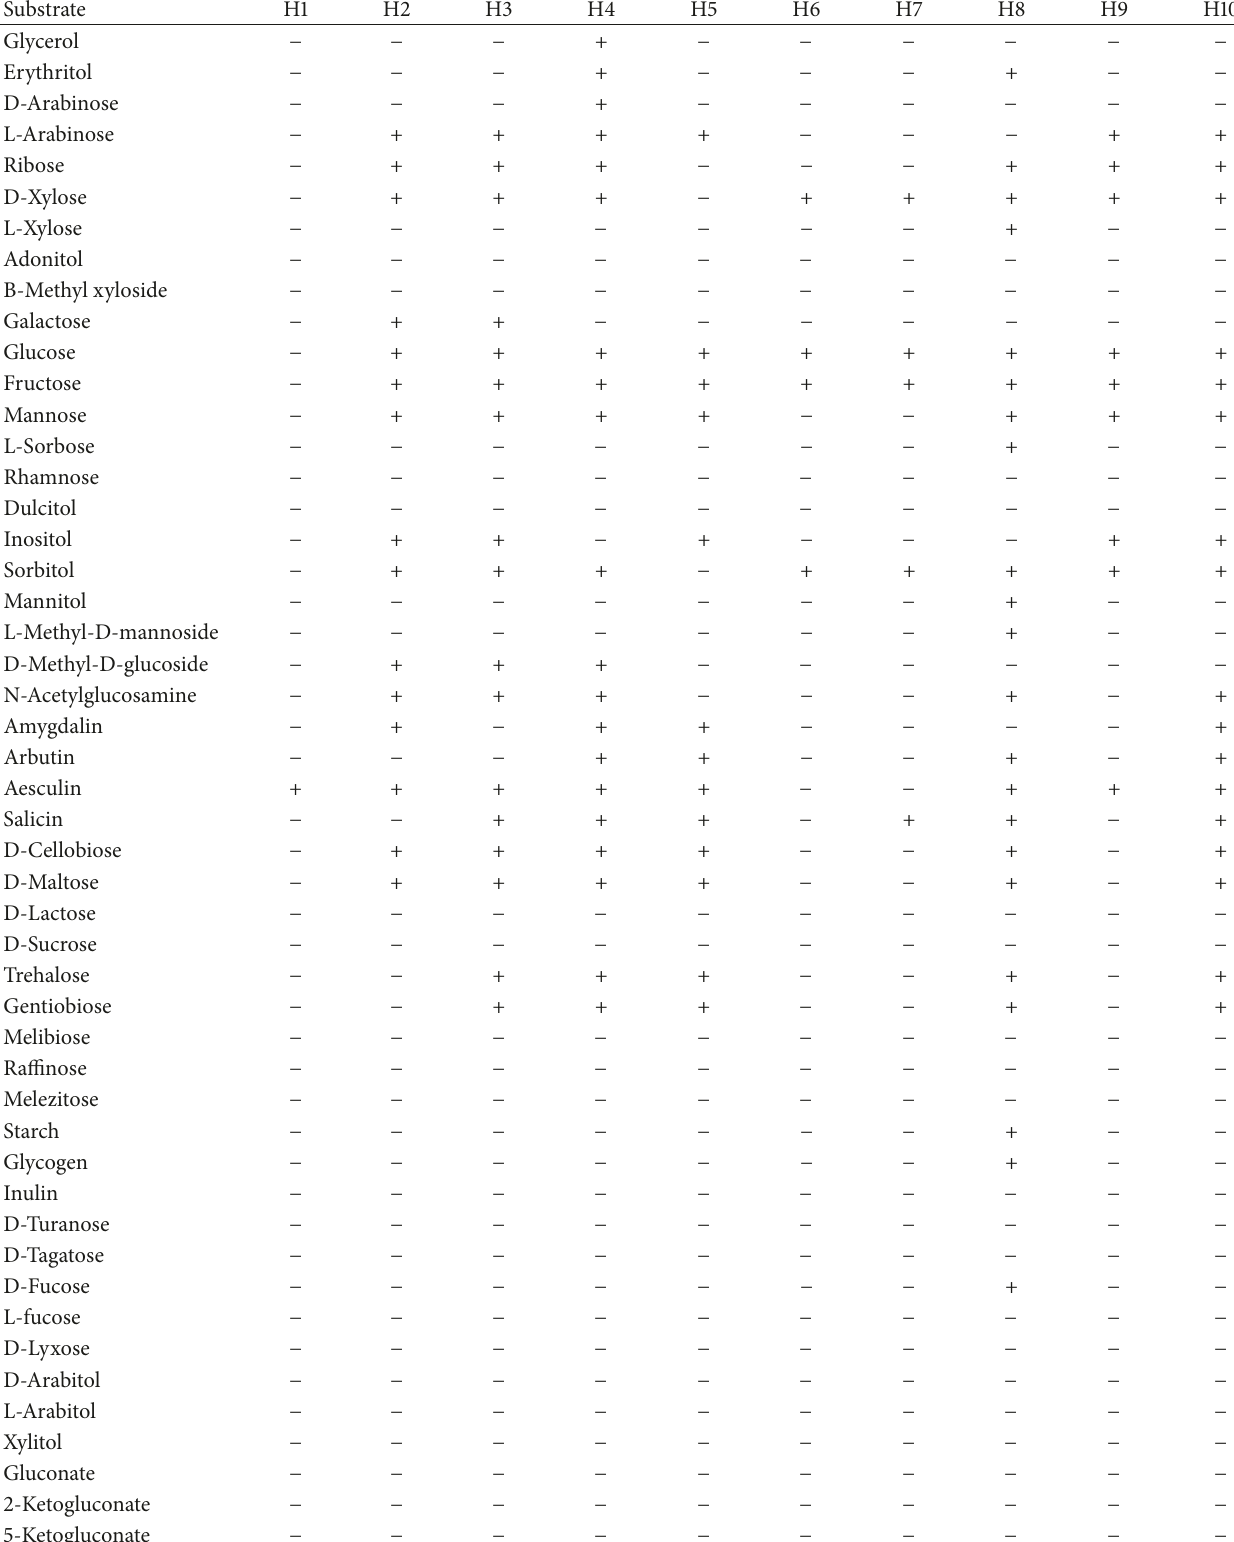
Table 3: Carbohydrate utilization profile using API 50CH for the ten